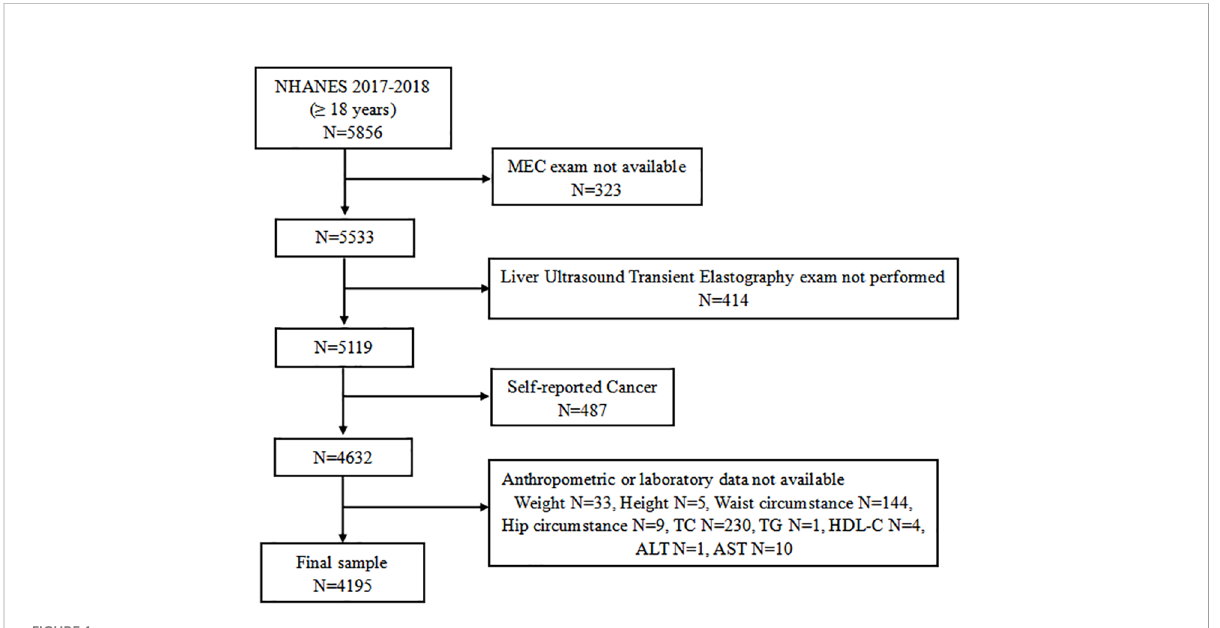
FIGURE 1 Flow chart of the research study